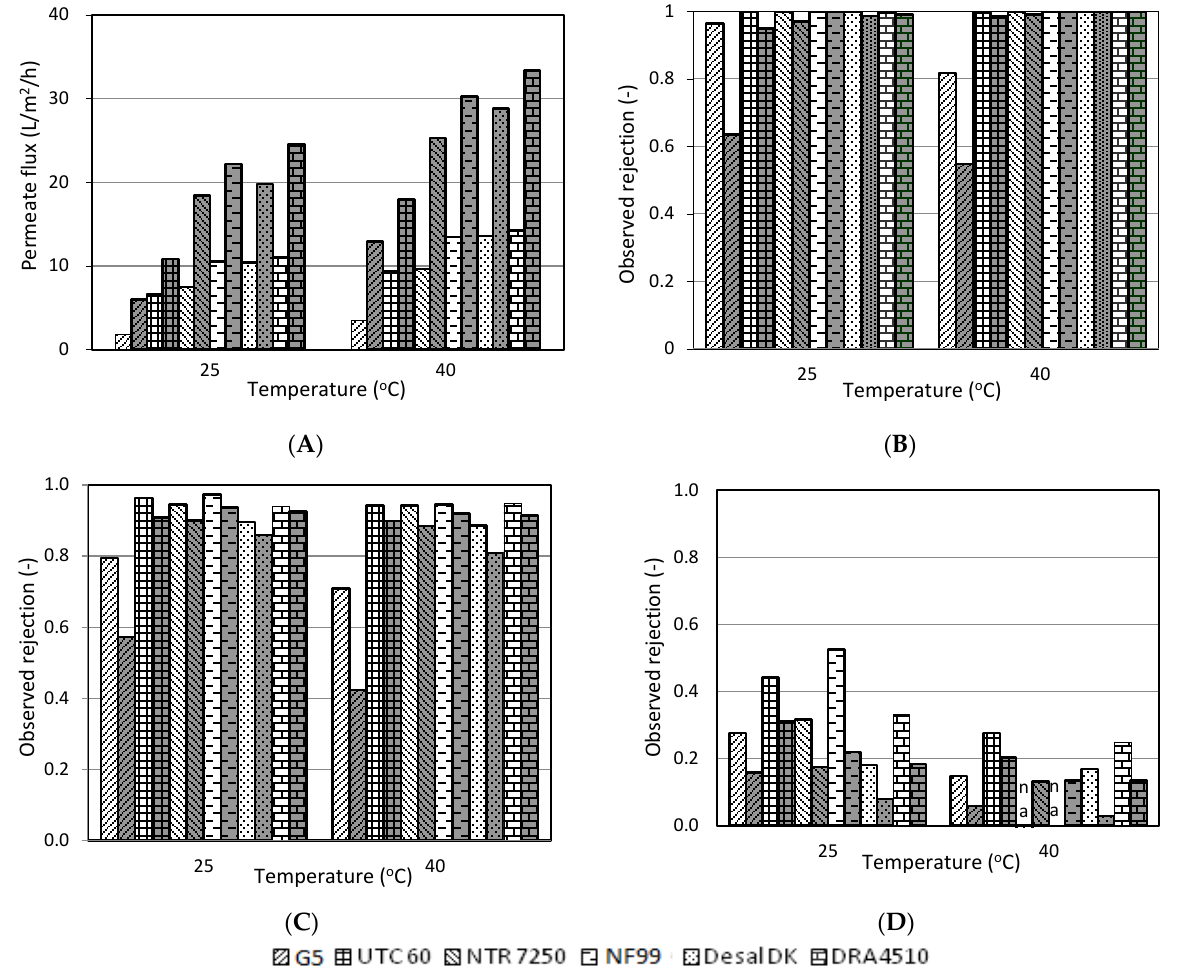
Figure 3. Effect of temperature on nanofiltration of cranberry juice. White background: fresh cranberry juice, grey background: UF cranberry juice. ( A ): permeate flux, ( B ): sugar rejection, ( C ): organic acid rejection, ( D ): benzoic acid rejection. The conditions of nanofiltration: operating pressure: 3 MPa, feed flow rate: 7.5 L/min, pH: 2.5 (na: non-available data).